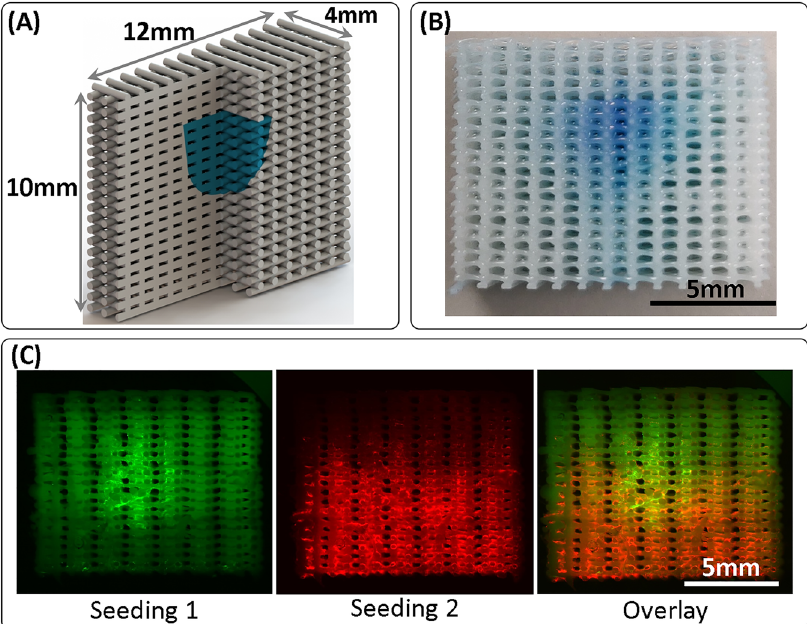
Fig. 6 Plasma treatment of scaffolds demonstrated successful patterning of cells deep within a 3D scaffold. A plasma-treated island was patterned deep within a scaffold, as depicted schematically, with the plasma-treated region colored blue ( A ). The patterned region was visualized for the plasma- polymerized VTMOS – MAA coating using methylene blue staining ( B ). The plasma-treated island was used to attach hMSCs stained green selectively, shown here for an Ar-only plasma-patterned scaffold ( C , seeding 1). A second cell seeding using a viscous culture media 27 was then used to attach hMSCs stained red on the rest of the scaffold ( C , seeding 2), demonstrating an approach to pattern two cell populations (overlay) using the plasma